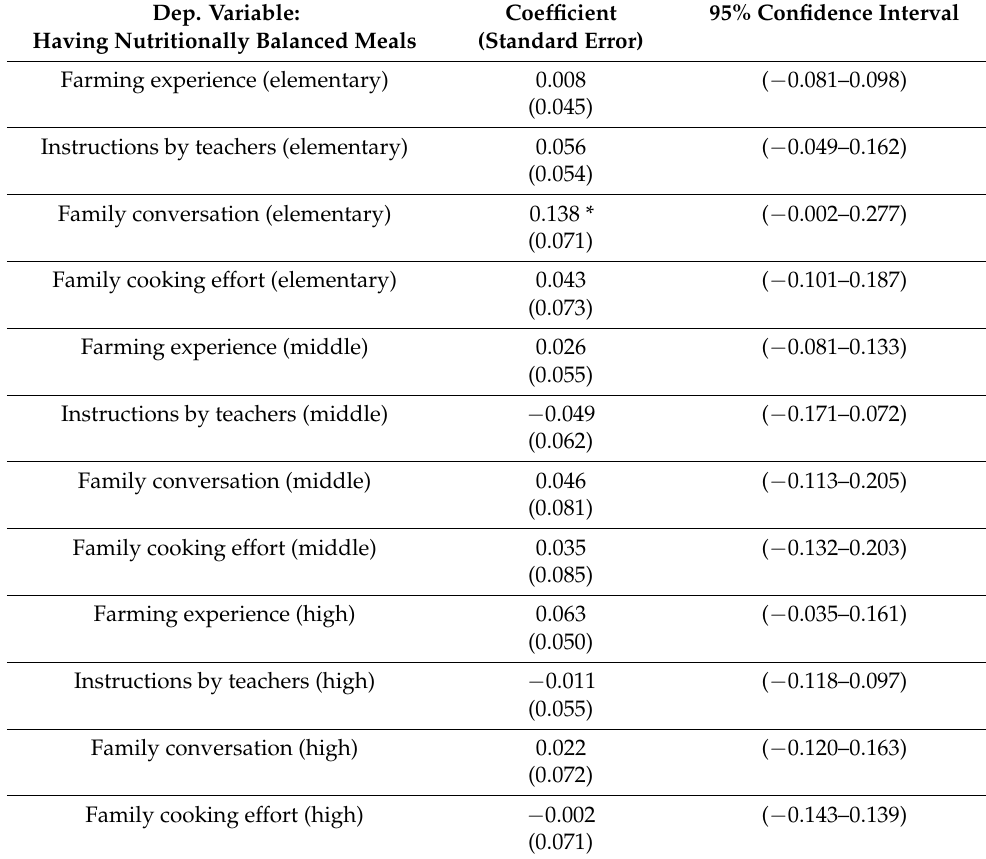
Table 4. Ordered logistic regression on the effects of nutrition education on having nutritionally balanced meals.